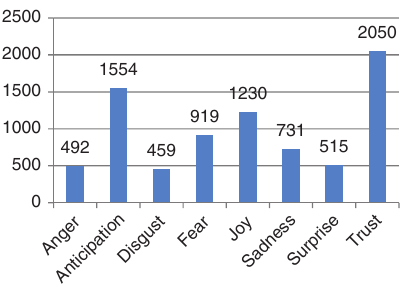
Figure 5: Results of geo-location analysis.